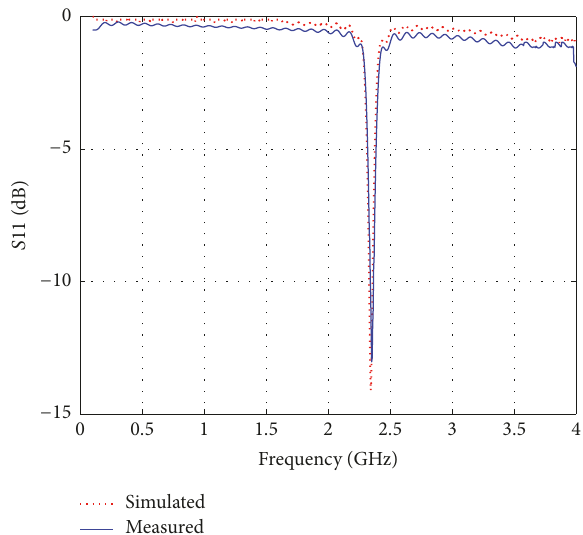
Figure 24: Comparison of measured and simulated 𝑆 11 .